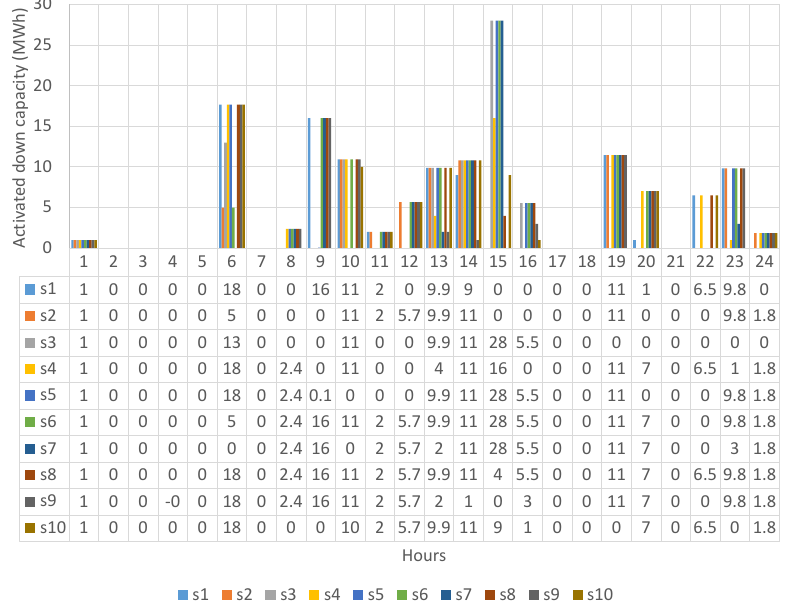
Figure 9. Activation of the battery storage down reserve ( q a ↓